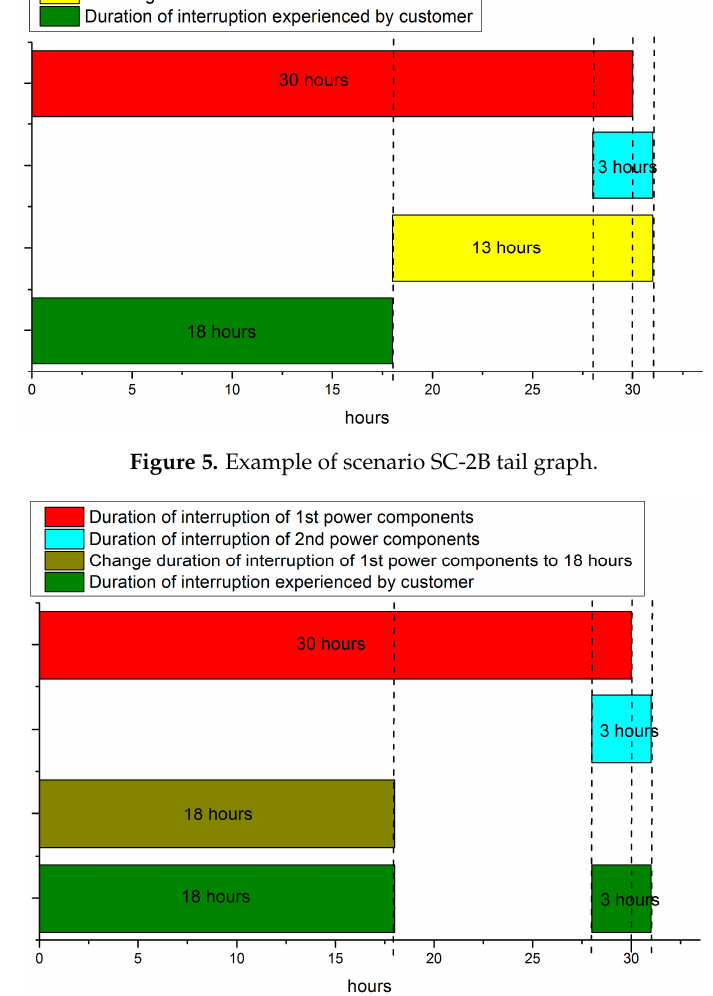
Figure 6. Example of scenario SC-3B tail graph.